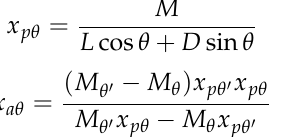
Figure 14. Moment coefficient at different flow velocities. ( a ) Pitch moment coefficient. ( b ) Yaw moment coefficient.